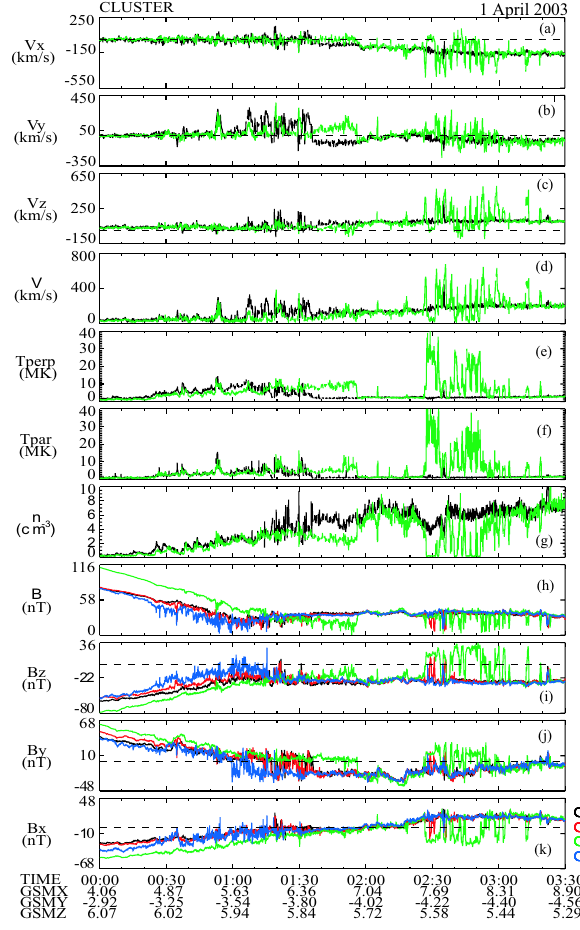
Fig. 3. The overview of the event showing the particle and the mag- netic field data. The top seven panels are the particle parameters obtained using HIA (only operative in C1 and C3). From top to bottom are the three components of the ion bulk velocity, its mag- nitude, the perpendicular and the parallel temperature, and the den- sity, respectively. The magnitude and the three components of the magnetic field for all of the four spacecraft are shown in the bottom four panels. The color scheme to represent the four spacecraft is the standard one: with C1 in black and C2 in red, and C3 in green and C4 in